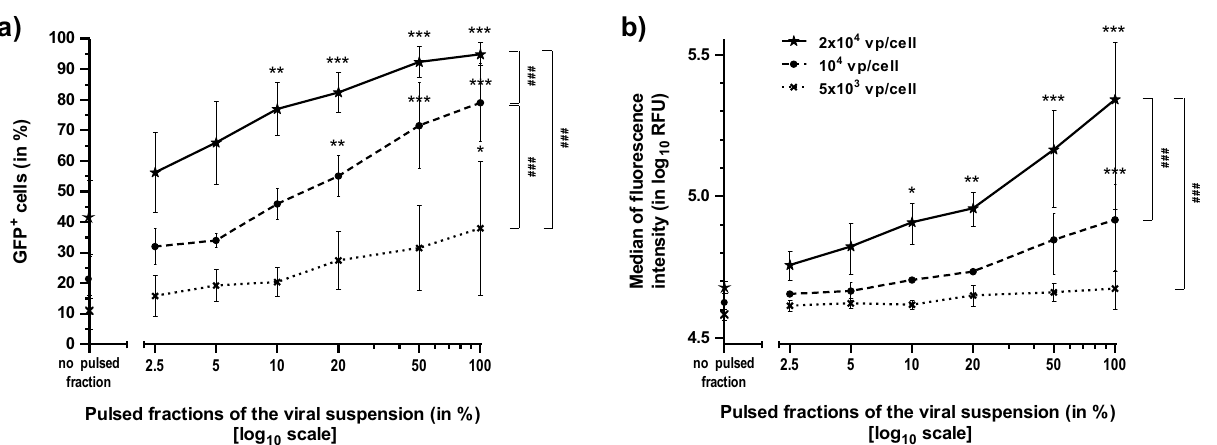
Figure 5. Analysis of GFP gene expression in L929 cells as a function of viral MOI and percentage of the viral suspension treated with LV pulses. S-MEM medium was mixed with rAd to obtain viral suspensions adjusted at three different MOI in vp/cell: 5 × 10 3 (black filled cross), 10 4 (black filled circle), and 2 × 10 4 (black filled star), when added to L929 cells. Pulsed fractions of the viral suspension (from 2.5 to 100%) were indicated on the X-axis, in log 10 scale for the sake of clarity. They were added to L929 cells that were analyzed by flow cytometry 48 h post treatment. ( a ) GFP + cells (in %), or ( b ) median of fluorescence intensity (in log 10 RFU) are presented. By comparison, the median level of L929 cell fluorescence in the absence of GFP expression (auto-fluorescence of uninfected cells treated with 100% of pulsed medium) was 3.77 ± 2.72 log 10 RFU. Data are presented as means ± SD (n = 3). Statistical significances for ( a,b ): * p < 0.05, ** p < 0.01, and *** p < 0.001 stand for intra-curve comparisons of GFP + cells and fluorescence intensity versus the “no pulsed fraction” condition; ### p < 0.001 for comparisons between curves representing different virus MOI (two-way ANOVA with Bonferroni’s